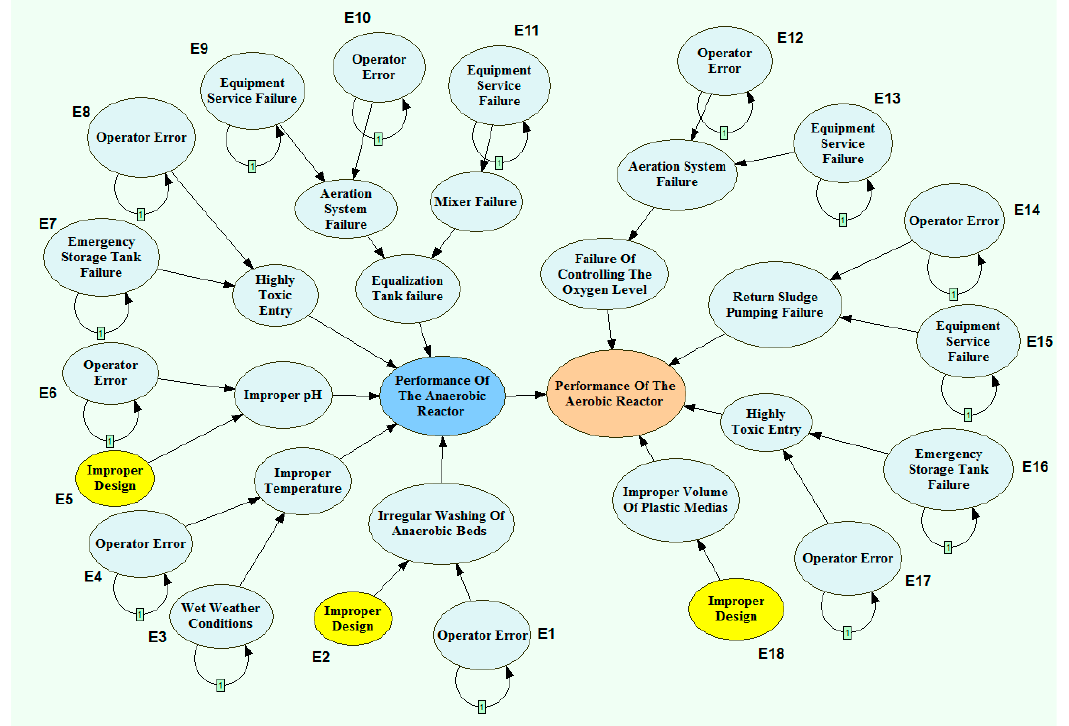
Figure 6. The DBN model of the MIC WWTP (part 1—anaerobic and aerobic reactors’ performance).